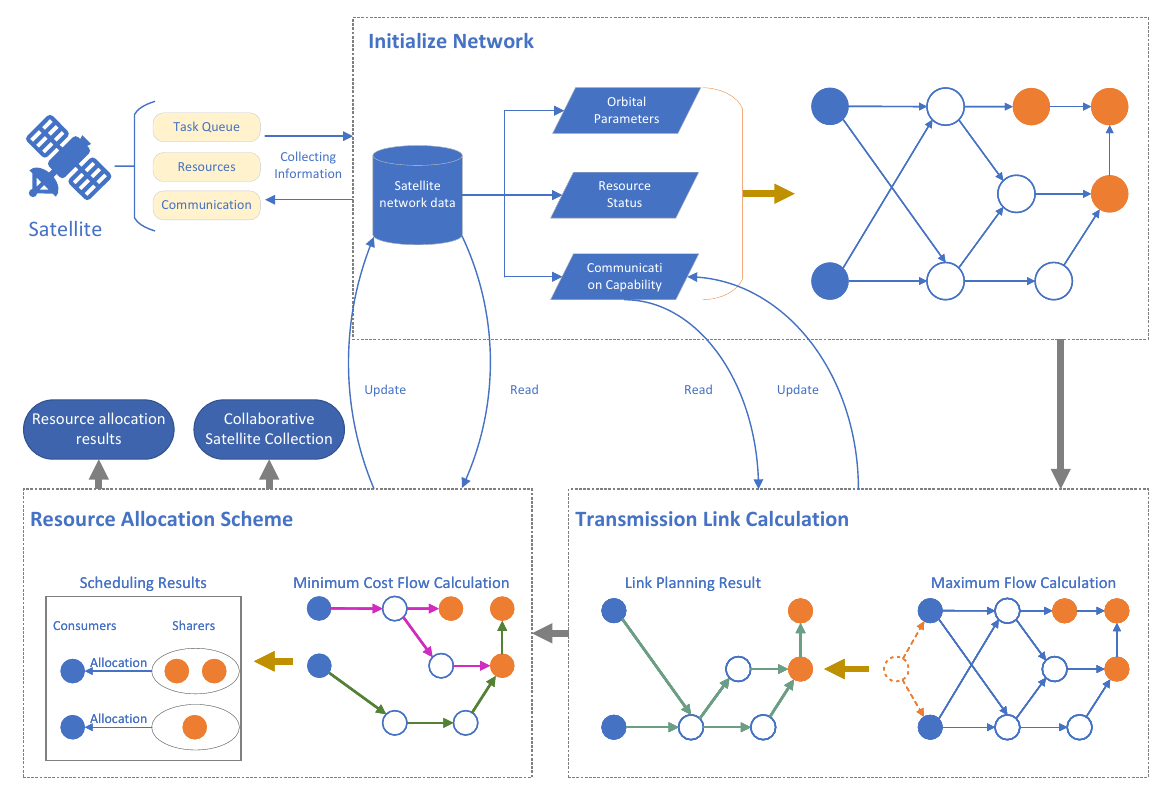
Figure 2. The multi-satellite resource collaborative scheduling method in spatial information